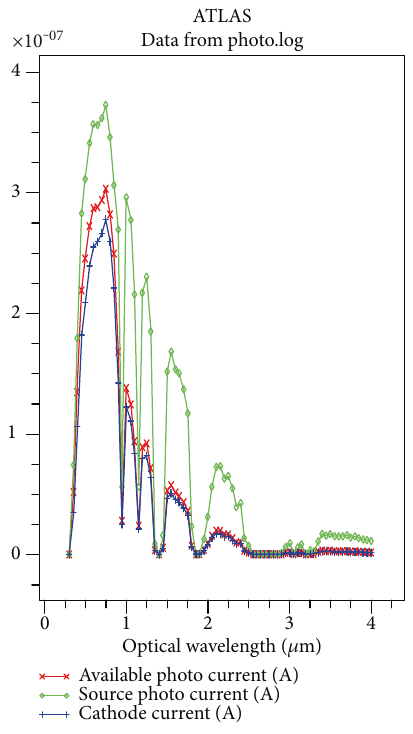
Figure 8: Generation of photocurrent by GaAs cell.